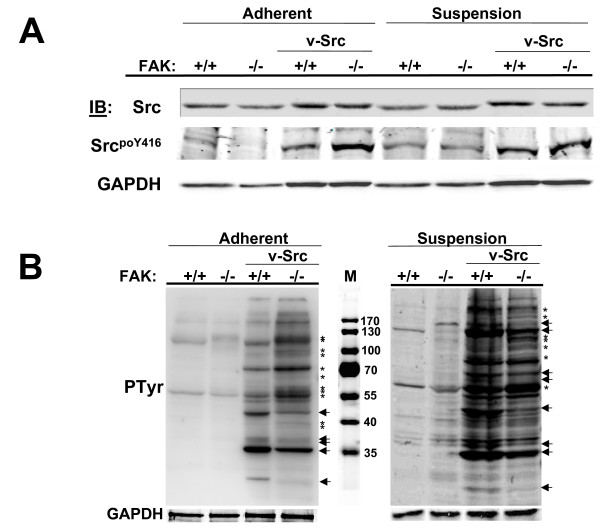
FAK- and adhesion-effects on v-Src substrate choice. (A) FAK+/+[puro], FAK-/-[puro], FAK+/+[v-Src] and FAK-/-[v-Src] cells grown in adherent or suspension conditions as described in Experimental Procedures were analyzed by IB for levels of total Src, SrcpoY416 autophosphorylation or GAPDH (as a loading control). [Note that the decrease in Src protein, SrcpoY416 and GAPDH levels in lane 2 (second from left) is not reproducible; relative Src activation levels in adherent FAK-/-[v-Src] cells are typically comparable to those in adherent FAK+/+[v-Src] cells]. (B) Anti-phosphotyrosine (MAb4G10) IB from equal protein loads of FAK+/+[puro], FAK-/-[puro], FAK+/+[v-Src] and FAK-/-[v-Src] cell lysates. M, proteins markers in kDa. Decreased Src-induced tyrosine phosphorylation events in the absence of FAK are marked by arrows whereas increased tyrosine phosphorylation events in the absence of FAK are marked by asterisks. These data are typical of at least three independent experiments. A GAPDH IB is shown below as a loading control.